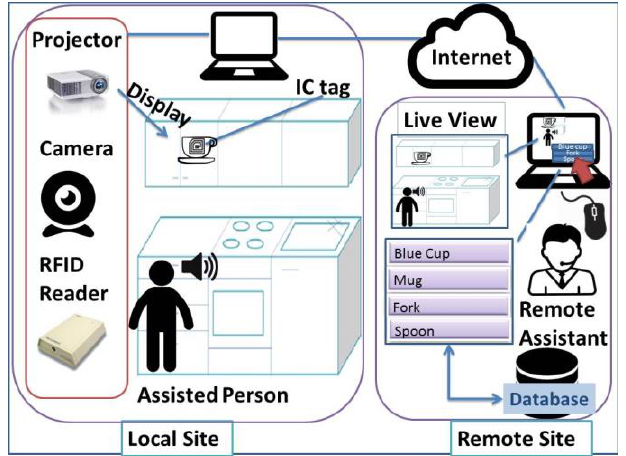
Figure 1 . Overview of the whole system: a local site where RFID and projection technology are installed to assist a person and a remote site where a caregiver using an application gives step-by-step instructions to that person via the Internet.